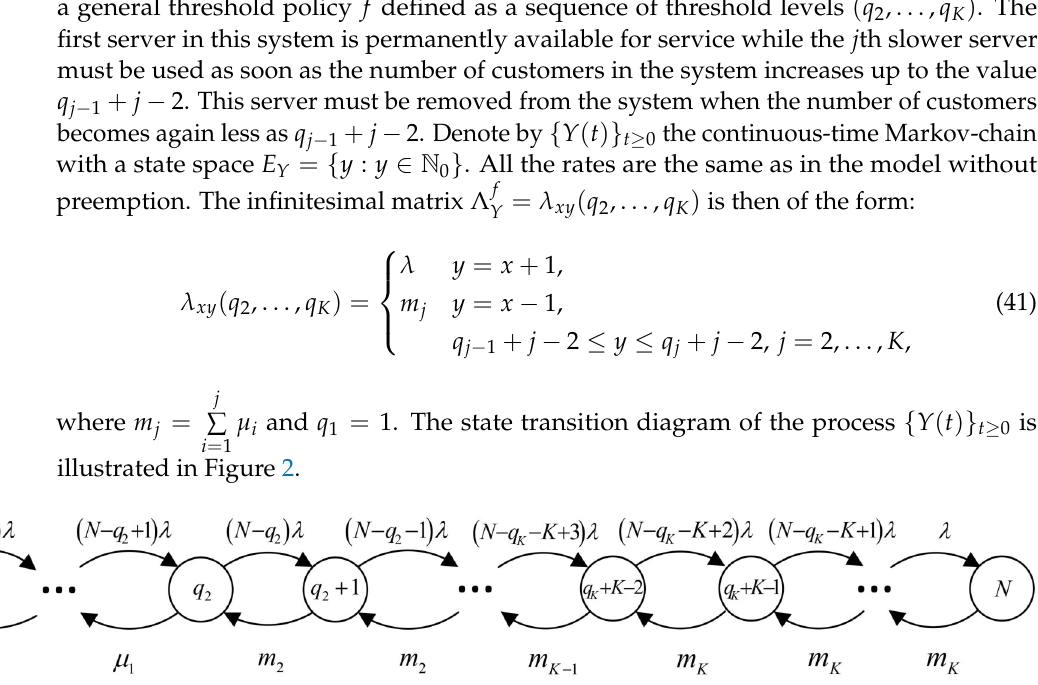
Figure 2. The state transition diagram for the queueing system S 2